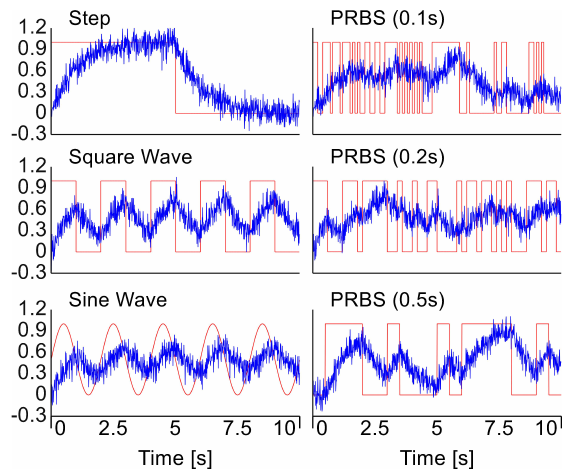
Figure 8: Six different input signals (red) are used to excite the first test case model. For each sig- nal, the model is simulated deterministically to obtain the output (blue). The three left panels show the Step, Square wave and Sine wave signals. The Square wave and Sine wave both have a period of T = 2 s . The right panels show the three pseudo random bin- ary sequence (PRBS) signals, which differ in what length in time each bit in the sequence represents (0 . 1 s , 0 . 2 s or 0 . 5 s ).